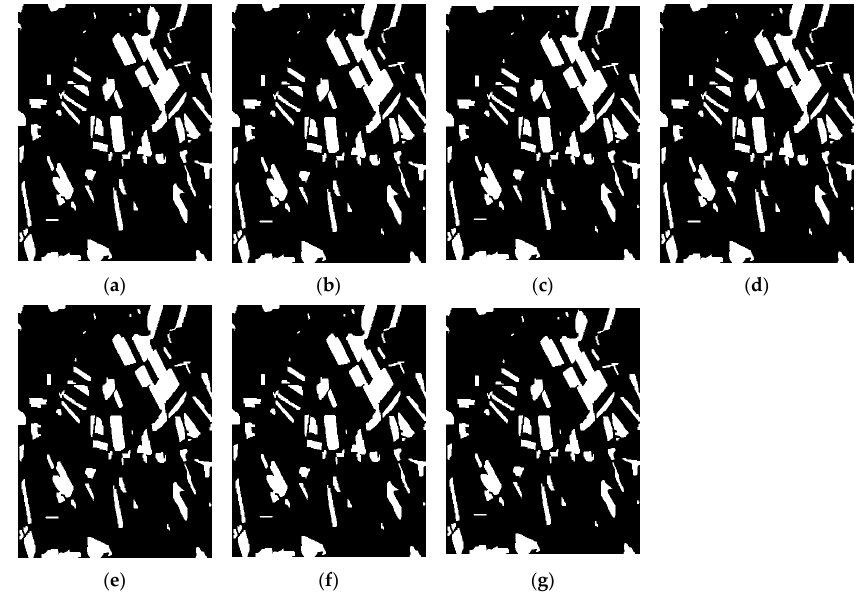
Figure 6. CD maps for a value of thresholds of ( a ) 0.6; ( b ) 0.65; ( c ) 0.7; ( d ) 0.75; ( e ) 0.8; ( f ) 0.85 and ( g ) 0.9 using the first segmentation map for Q = 64.